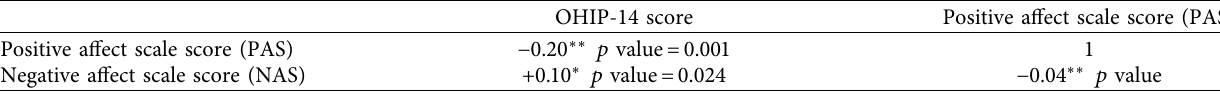
Table 2: Correlation matrix of OHIP-14 scores and PAS score and NAS score (Pearson’s correlation ( r )). OHIP-14